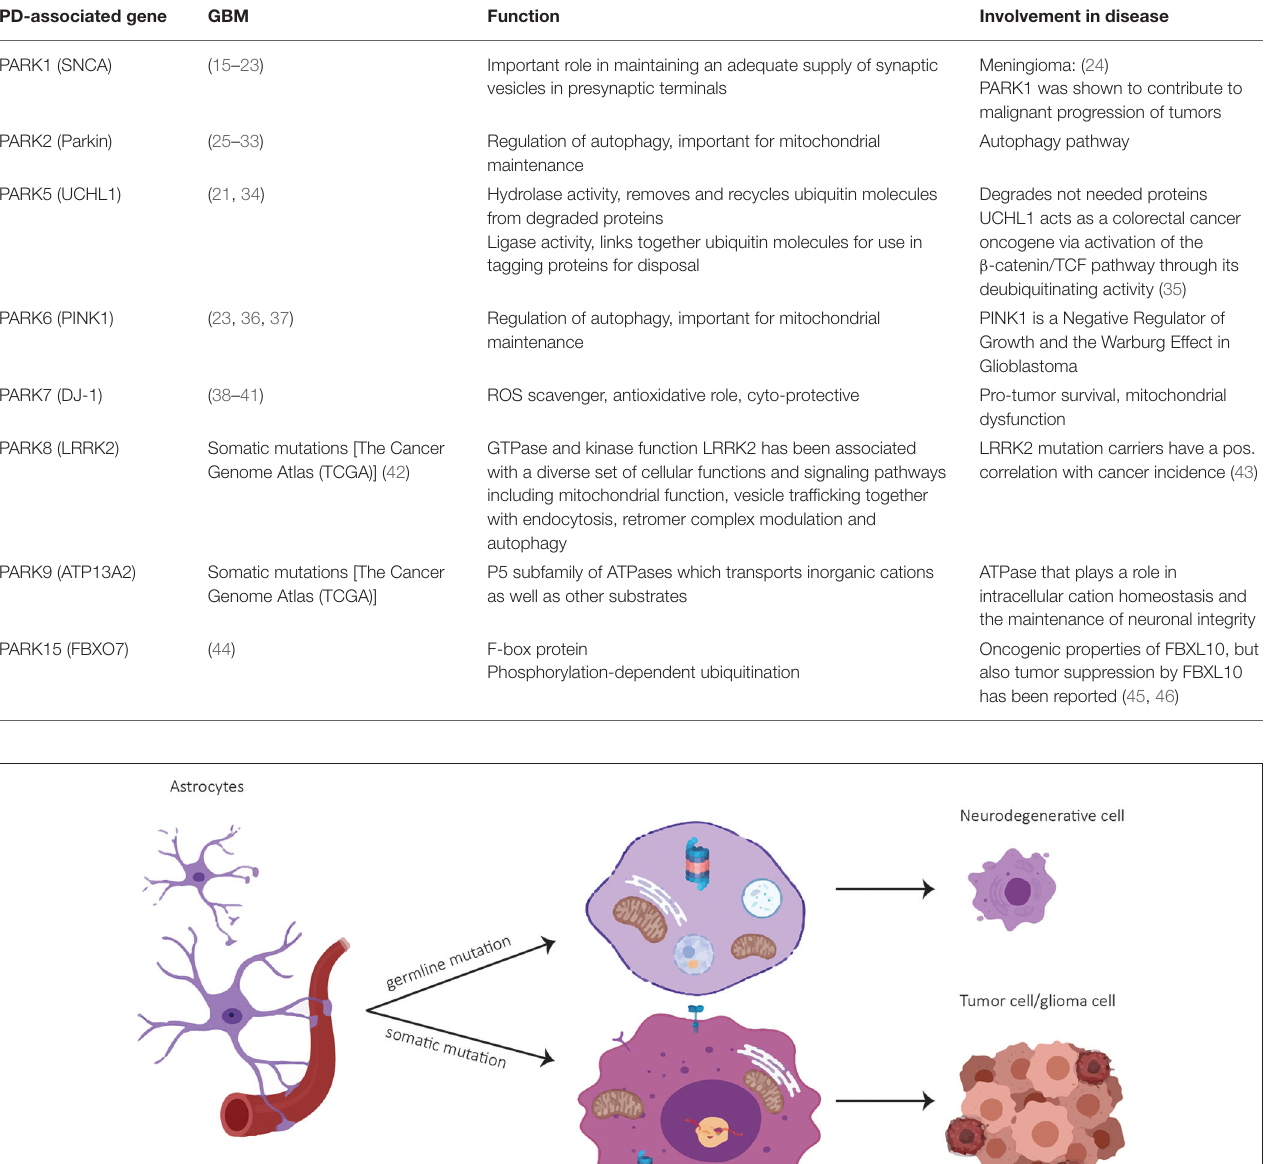
TABLE 1 | Overview PD-genes in GBM.